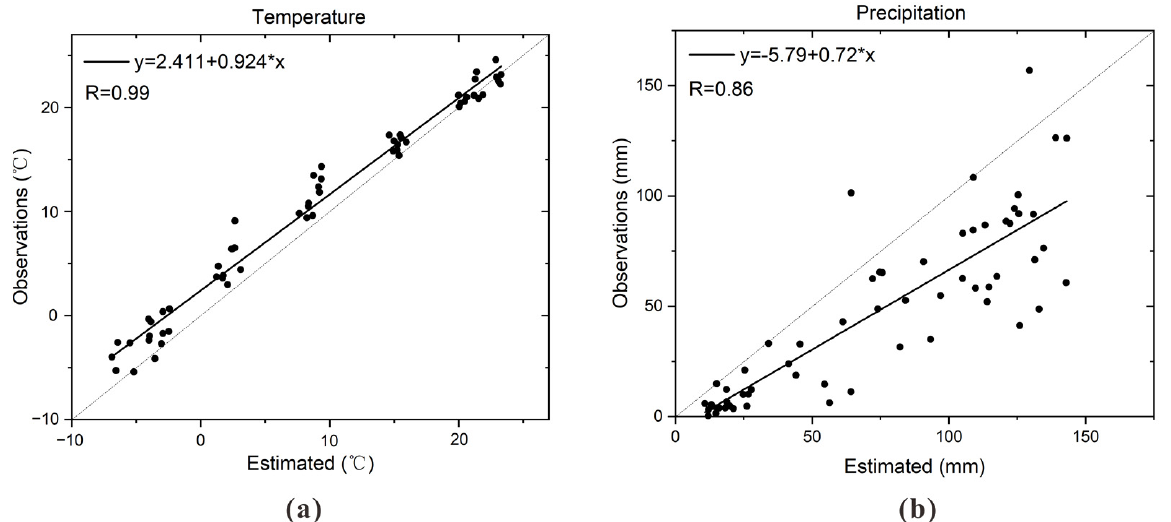
Figure 2. Observed versus estimated monthly ( a ) temperature and ( b ) precipitation from 2015 to 2019. The linear fitting formulas for temperature and precipitation are